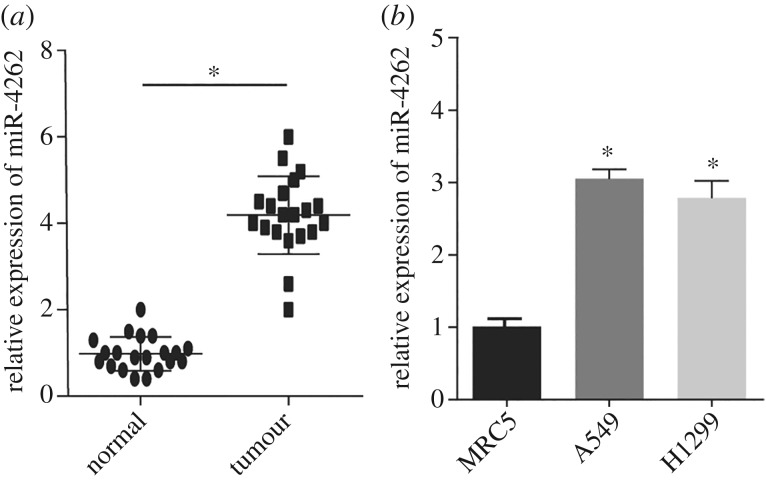
miR-4262 expression is upregulated in NSCLC tissues and cells. (a) qRT-PCR showed the miR-4262 expression level in 20 carcinoma samples and in 20 adjacent non-cancerous samples. (*p < 0.05). (b) The expression levels of miR-4262 were assessed by qRT-PCR in the NSCLC cell lines A549 and H1299 and in the fetal lung fibroblast cell line MRC5 (*p < 0.05 versus the MRC5 group).